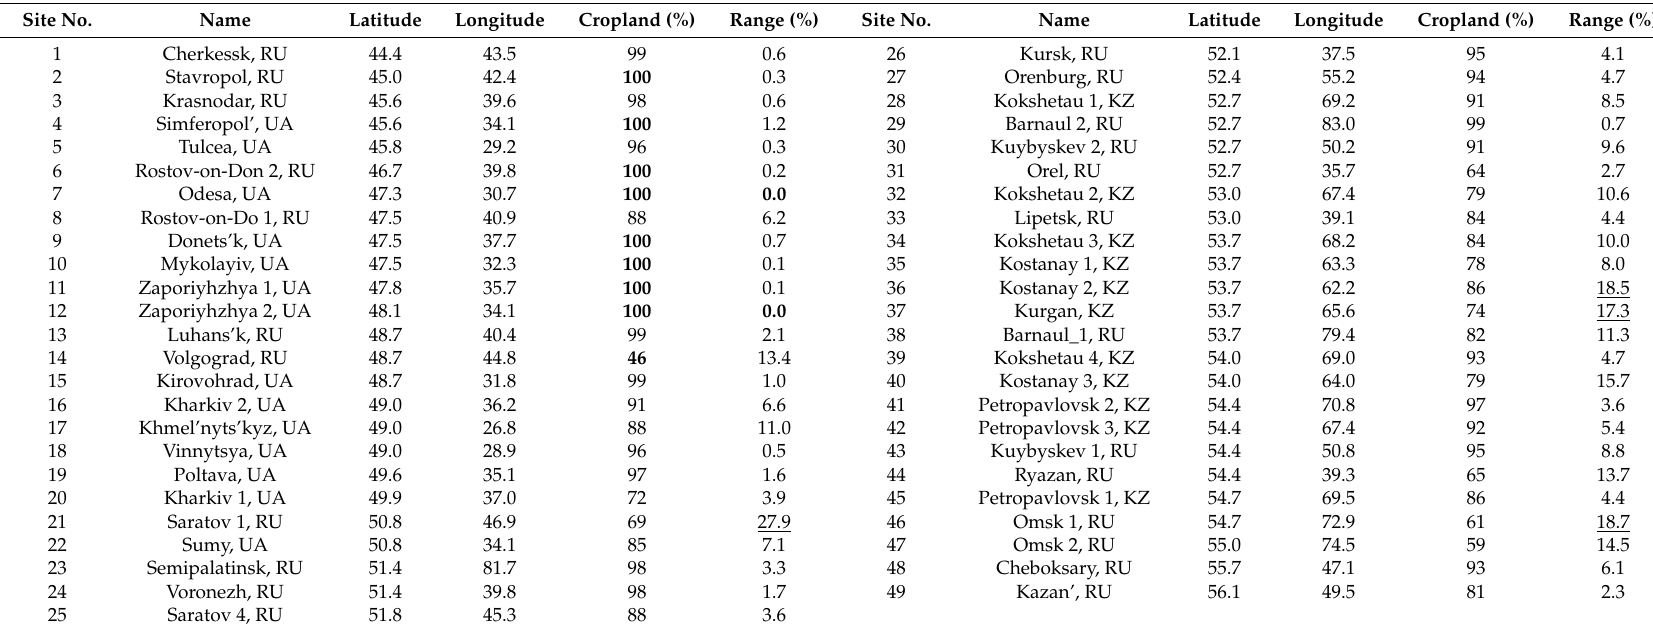
Table 3. Description of 49 study sites named by their closest town and country, numbered from lower latitude (1) to higher latitude (49), their geographic coordinates, and average cropland (CRP) cover percent and range (2003–2010). Note sites with 100% average CRP cover throughout the study period (bold), and larger CRP cover percent range